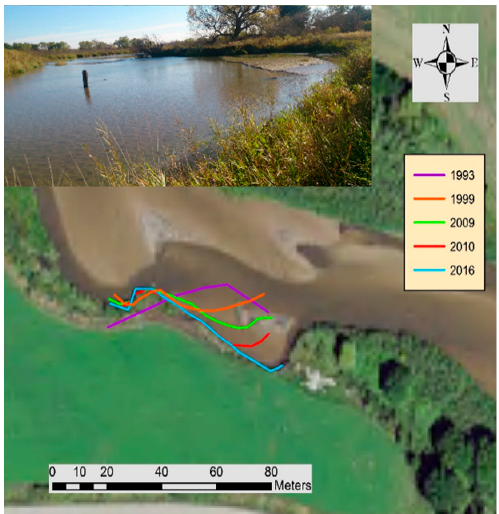
Figure 4. Site 11 in 2016. This site had two jetties that failed (insert). The flow direction is from left to right. The streambank retreat was measured by drawing a polyline where the streambank was for each aerial image. The area between the polylines was then calculated for each period.